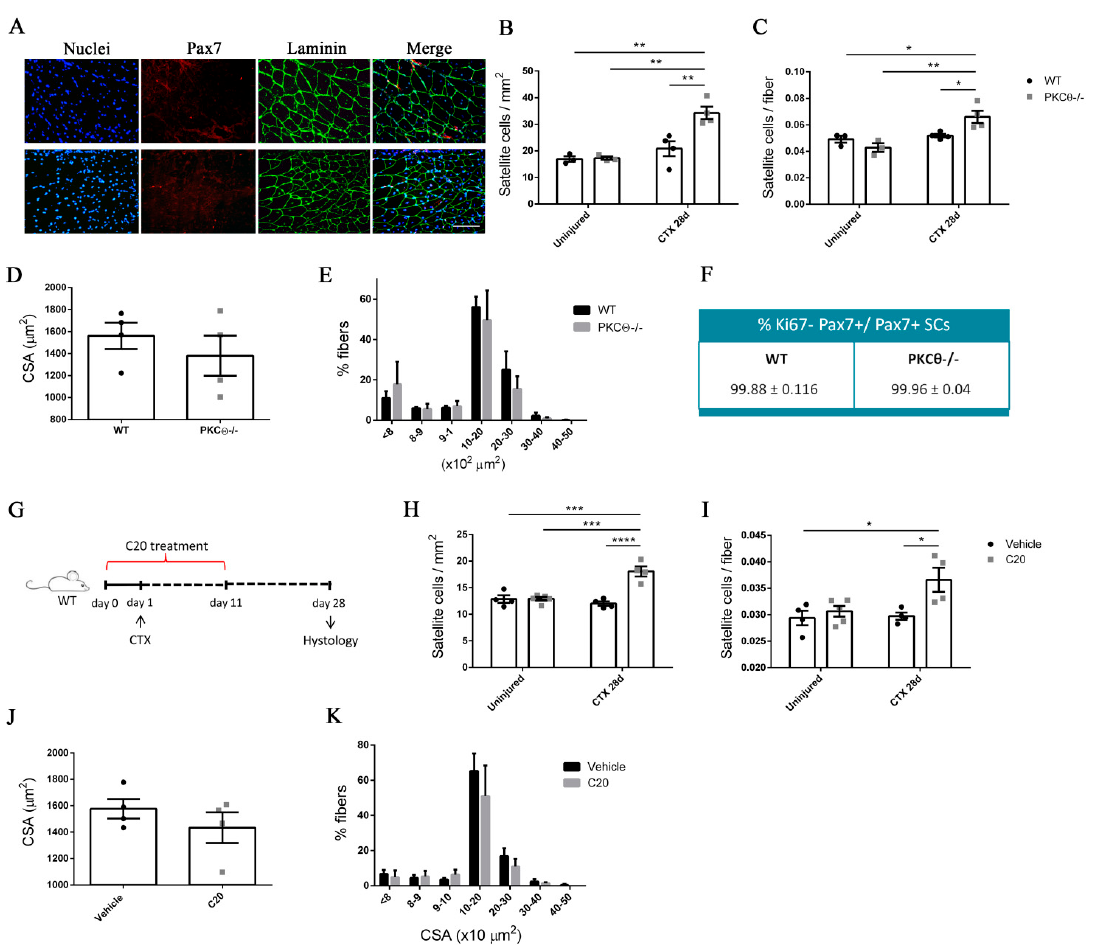
Figure 5. PKC θ absence/inhibition increases the quiescent satellite cell pool after induction of acute injury. ( A ): Representative immunofluorescence pictures of WT and PKC θ - / - GA sections, 28 days after CTX injury. Sections were stained for Pax7 (red) and Laminin (green). Nuclei were counterstained with Hoechst. Scale bar: 100 µ m. ( B ): Number of SCs per mm2 and ( C ): number of SCs per fiber in uninjured and 28 day-injured GA muscle, in WT and PKC θ - / - mice. ( D ): Mean CSA and ( E ): CSA distribution of muscle fibers in WT and PKC θ - / - GA sections, 28 days after injury. ( F ): Quantification of non-proliferating SCs 28 days after CTX injury, in WT and PKC θ - / - GA, identified by immunofluorescence co-staining for Pax7 and Ki67. (WT, n = 4 mice, PKC θ - / -, n = 4 mice). ( G ): experimental plan for in vivo C20 treatment in injured muscle. ( H ): Number of SCs per mm 2 and ( I ): number of SCs per fiber in uninjured and 28 day-injured GA muscle, in WT mice treated with C20 or vehicle. ( J ): mean CSA and ( K ): CSA distribution of muscle fibers in WT mice treated with C20 or vehicle, 28 days after injury. (C20 treated WT, n = 4 mice, Vehicle treated WT n = 4 mice). Error bars represent mean ± sem, * p < 0.05, ** p < 0.01 *** p < 0.001, **** p < 0.0001 calculated by Two-way Anova with adjustment for multiple comparison